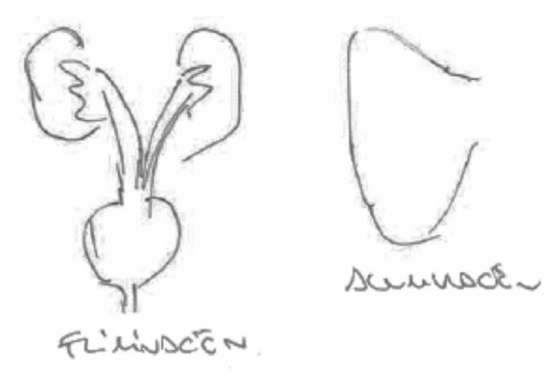
Figure 15. Breastfeeding, university education,